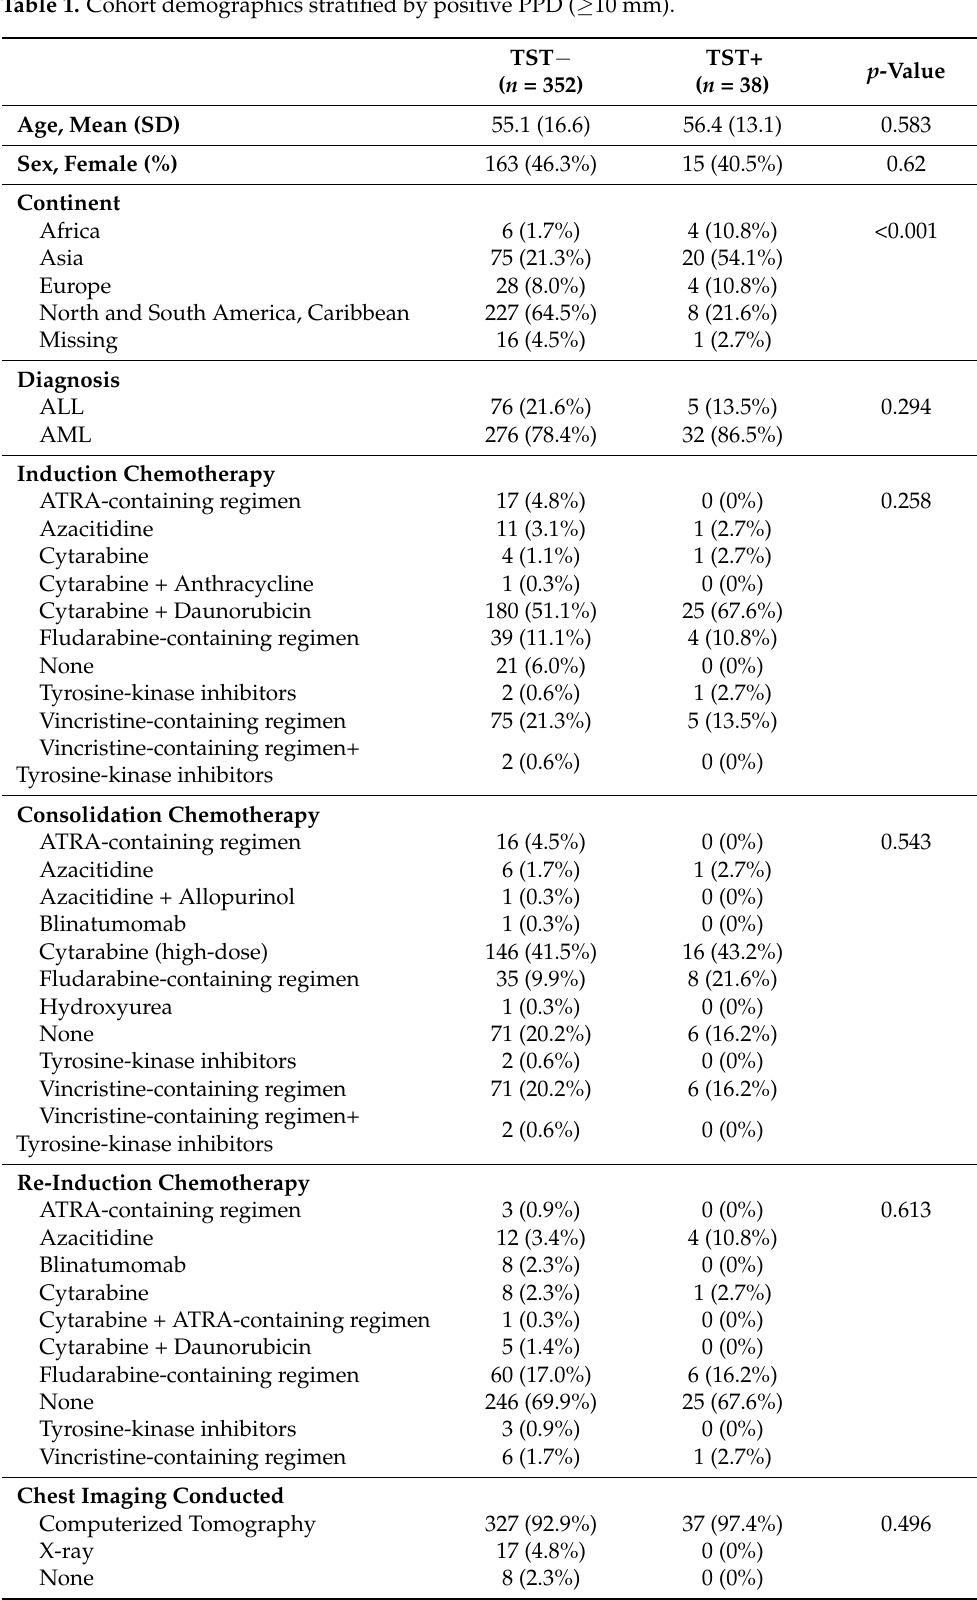
Table 1. Cohort demographics stratified by positive PPD ( ≥ 10